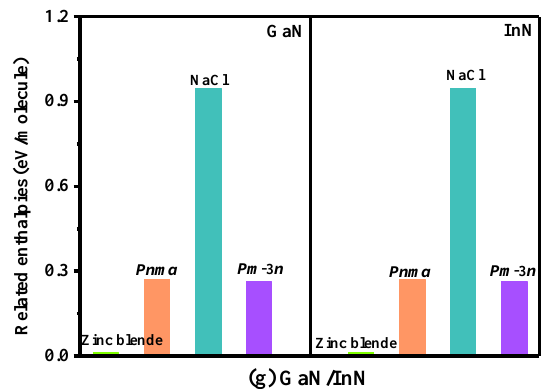
Figure 2. The phonon spectra of BN ( a ), AlN ( b ), GaN ( c ), InN ( d ) in the Pm − 3 n phase, and related enthalpies of BN ( e ), AlN ( f ), GaN and InN ( g ).